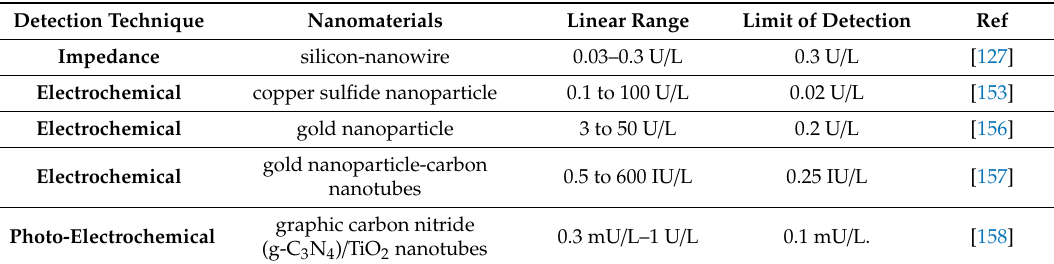
Table 2. Number of nanomaterials for enhancing electrochemical